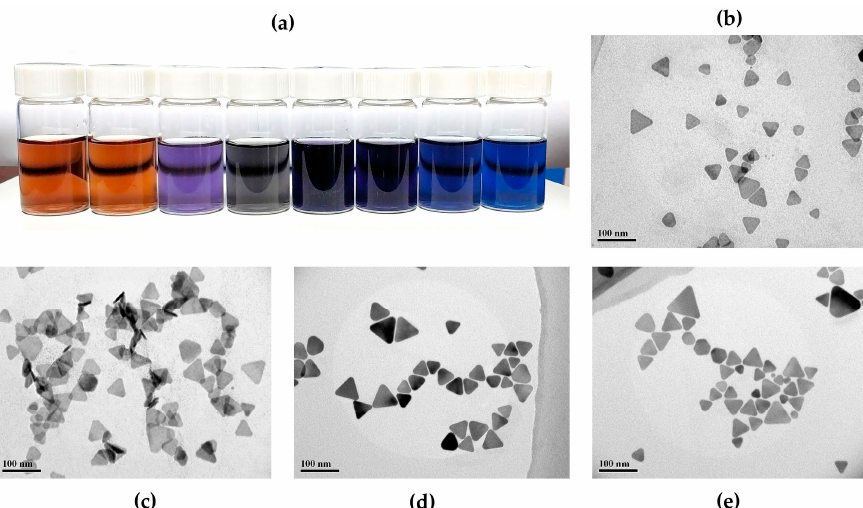
Figure 3. Synthesis of nanoprisms with different diameters. ( a ) The photograph of AgNPs synthesized through the lab-on-chip systems. TEM micrographs of the Ag nanoprisms under different synthesis